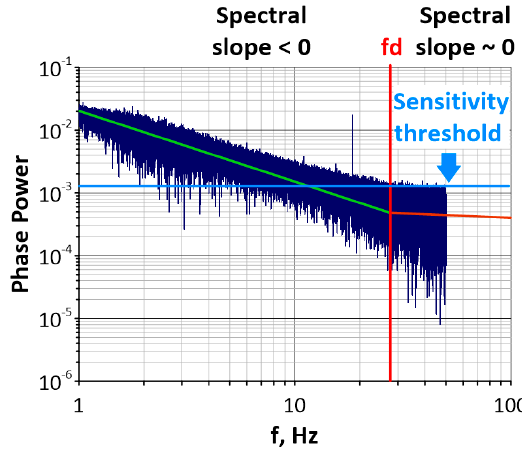
Figure 1. Deviation frequency and the sensitivity threshold of the GNSS sounding methods.